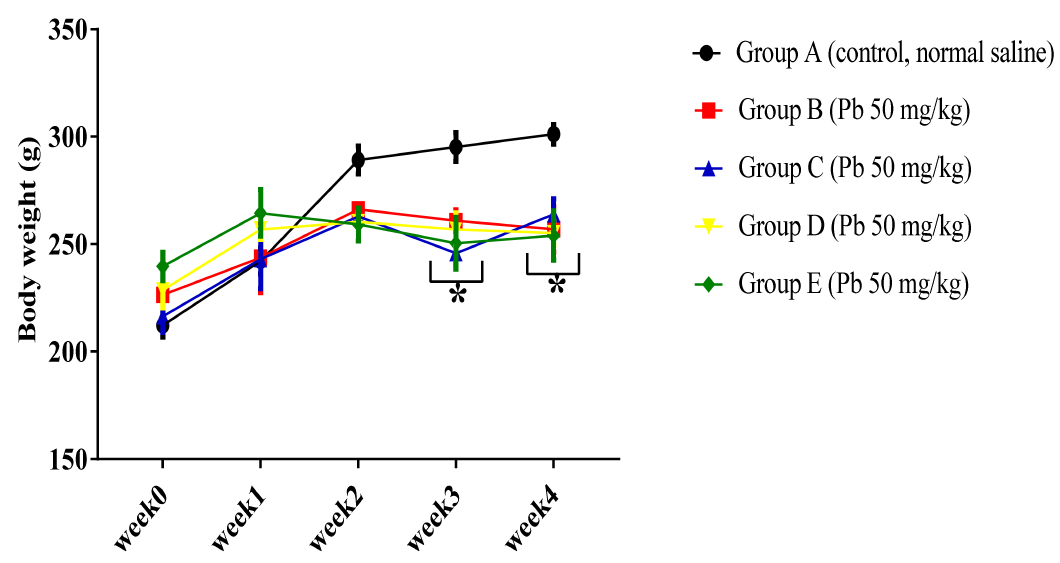
Figure 2. E ff ect of Pb toxicity on body weight following four weeks of oral administration Pb acetate. Data are represented as mean ± SEM ( n = 6); * p < 0.05 vs. control.